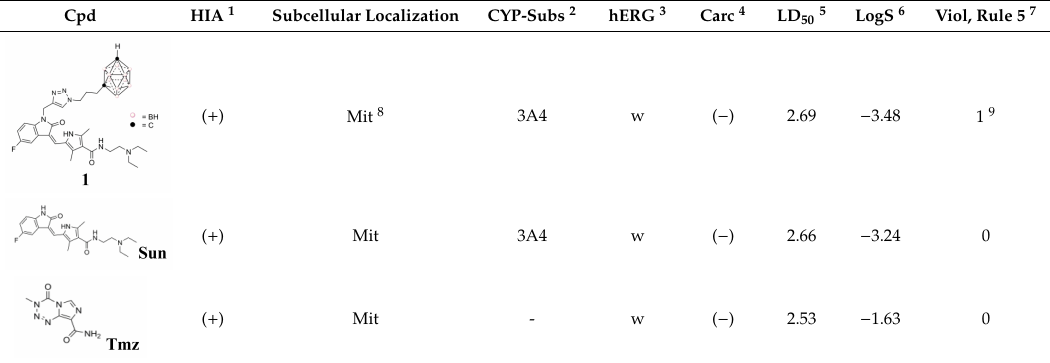
Table 3. Predicted drug-like properties of compound 1 , Sun , and Tmz